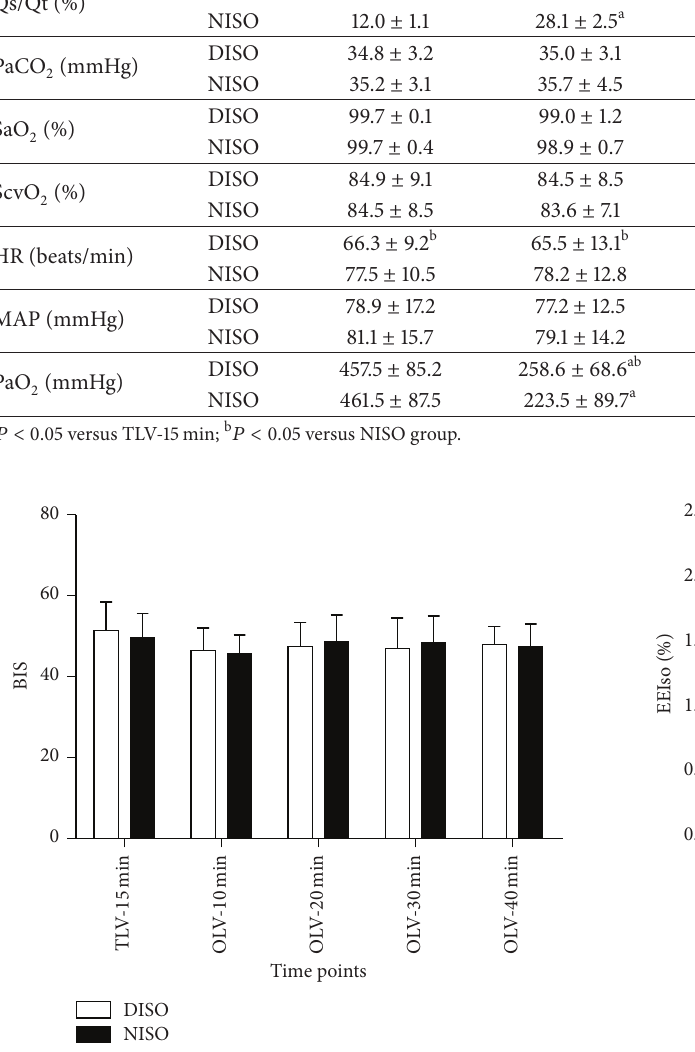
Figure 2: Perioperative time-course alterations of the end- expiratory isoflurane concentration (EEIso) in DISO group and NISO group. The values were measured as follows: 15 min after two-lung ventilation (TLV-15), 10 min after one-lung ventilation (OLV-10 min), 20 min after one-lung ventilation (OLV-20 min), 30 min after one-lung ventilation (OLV-30 min), and 40min after one-lung ventilation (OLV-40 min). Data are presented as median (interquartile range). ∗ 𝑃 < 0.05 intergroup comparison between group DISO and group